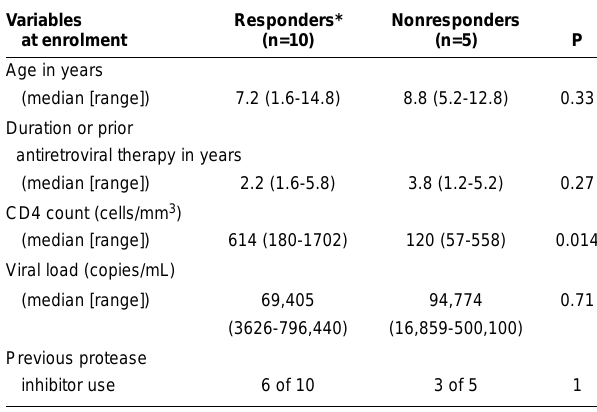
TABLE 3 Potential predictors of the likelihood of a